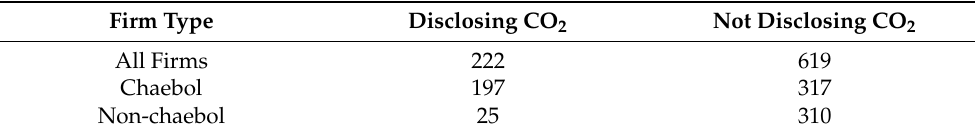
Table 2. Summary of Korean firms’ disclosing CO 2 .